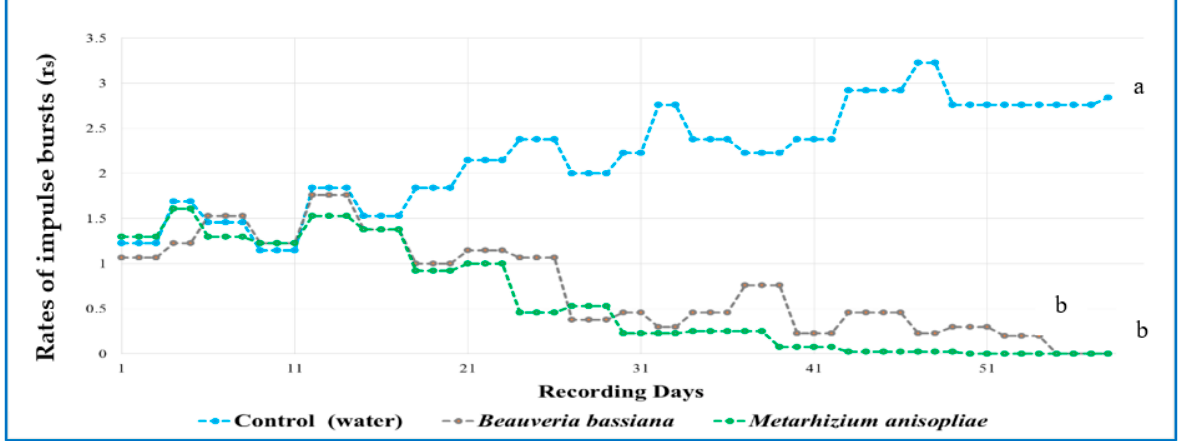
Figure 8. The mean rates of bursts per day of sound recording produced by red palm weevil larval activity inside the infested date palms is shown from the first day of injection to the last day of recording in treated trees and in control trees.